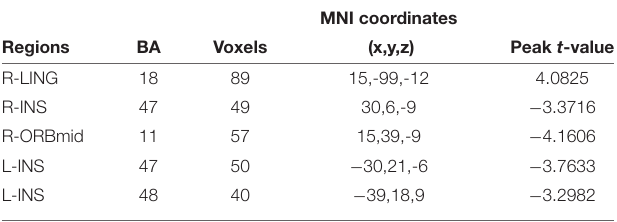
TABLE 3 | Brain regions showing significant differences in amplitude of low-frequency fluctuation (ALFF) between LBC and